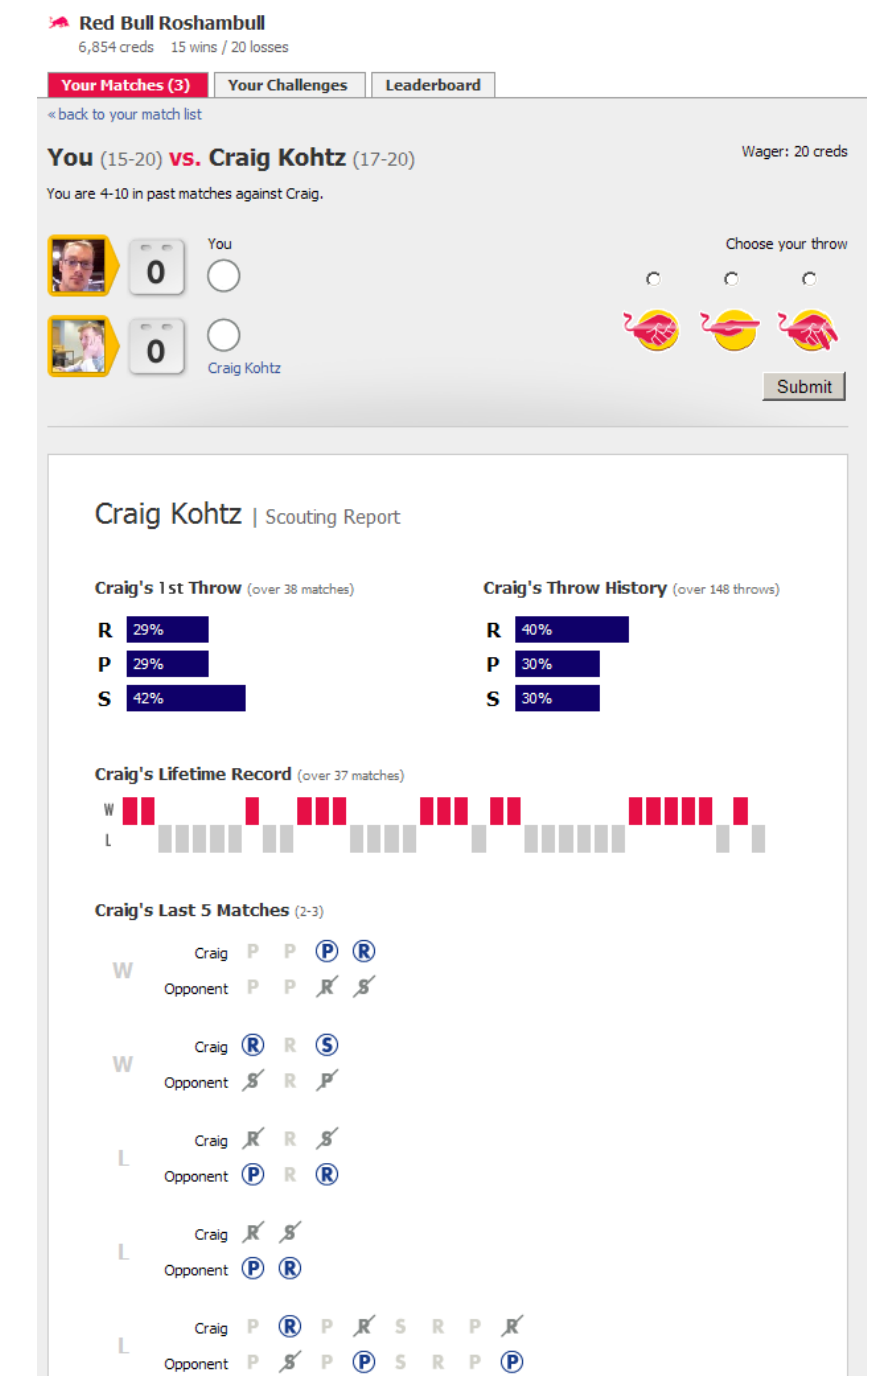
Figure 1. Screenshot of the Roshambull